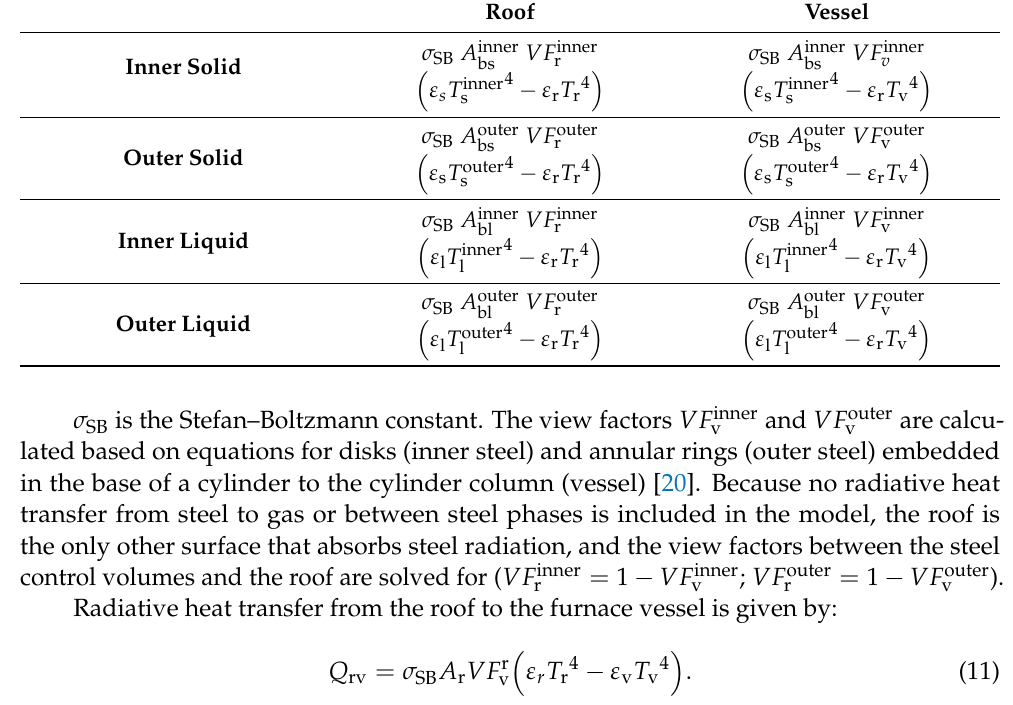
Table 3. Radiative heat transfer between different masses in the furnace. The subscript letters (s, l, b, r, v) refer to (solid steel, liquid steel, liquid slag, roof, vessel), respectively. Roof Vessel VF inner r σ SB A inner bs Inner Solid